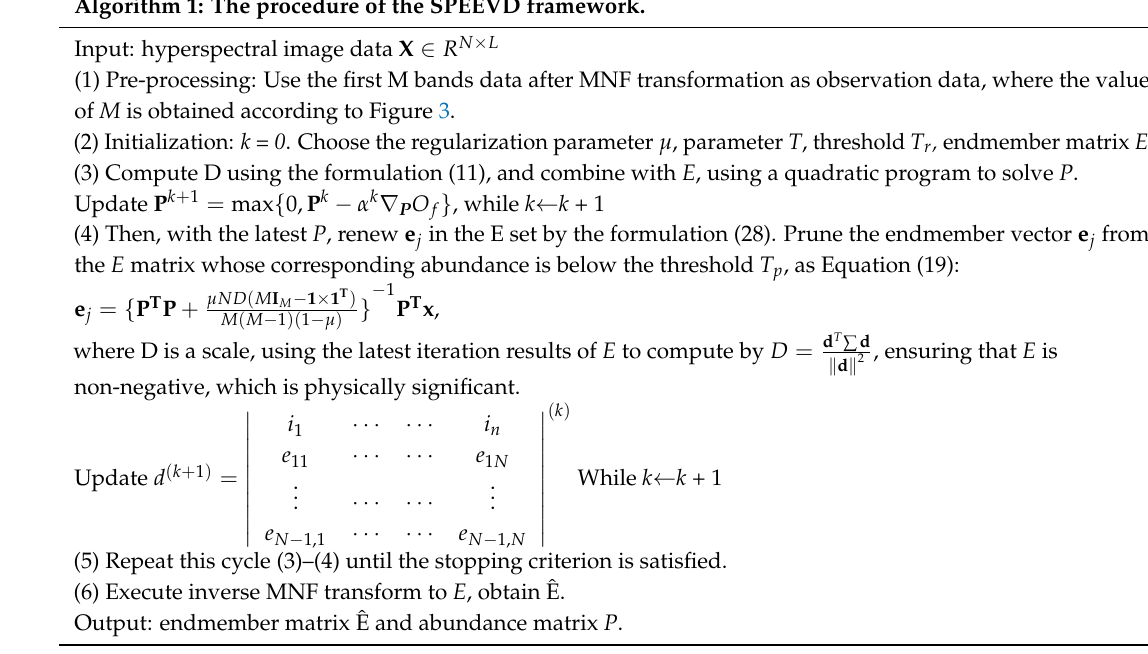
Algorithm 1: The procedure of the SPEEVD